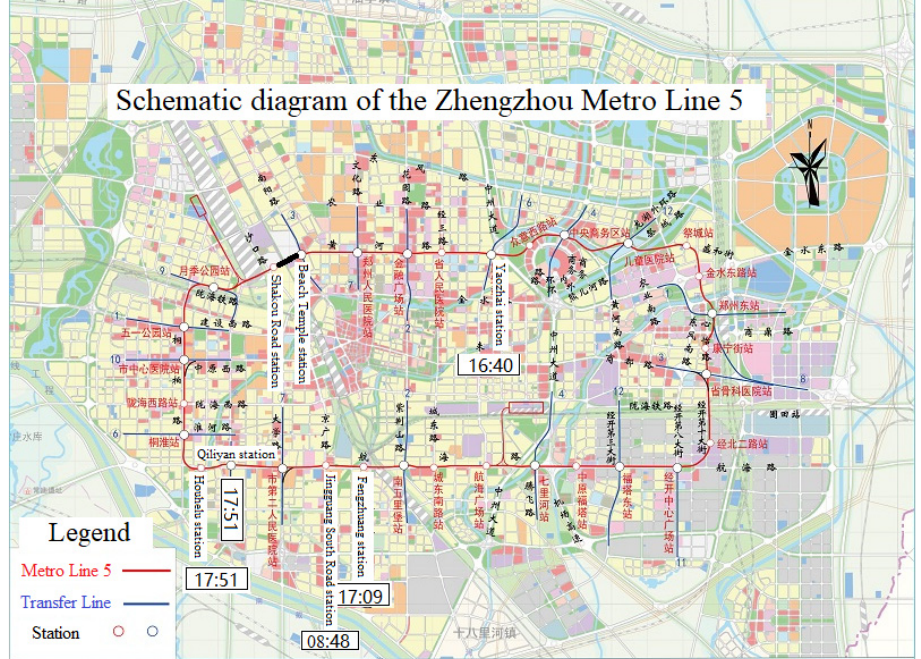
Figure 15. Schematic diagram of the Zhengzhou Metro Line 5 (redrawn from [27]). It has the largest daily passenger capacity of the seven existing Metro lines on weekdays, according to the data from the Weibo of Zhengzhou Metro [28], as shown in Figure 16. On July 20, serious ground waterlogging occurred around the Wulongkou parking area on the line, caused by heavy rainfall. At about 18:00 in the rush hour, water gushed across the retaining wall of the entry and into the main line area, which resulted in a train stopping between the Shakou Road station and the Beach Temple station, shown as a black line in Figure 15. More than 500 people were stranded [29]. On the same day, some